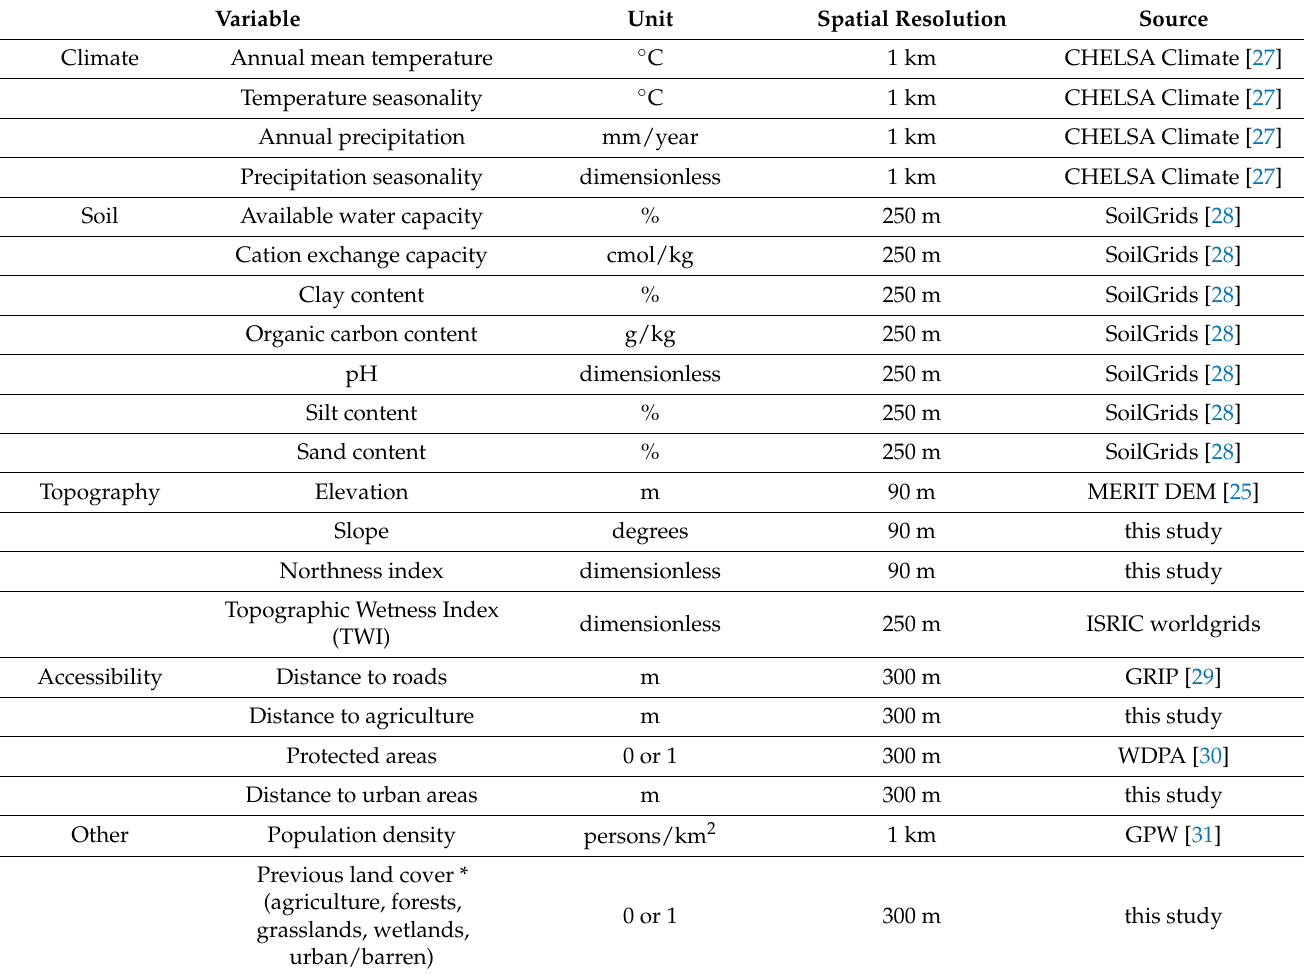
Table 1. List of predictor variables with original units and spatial resolution (prior to resampling and